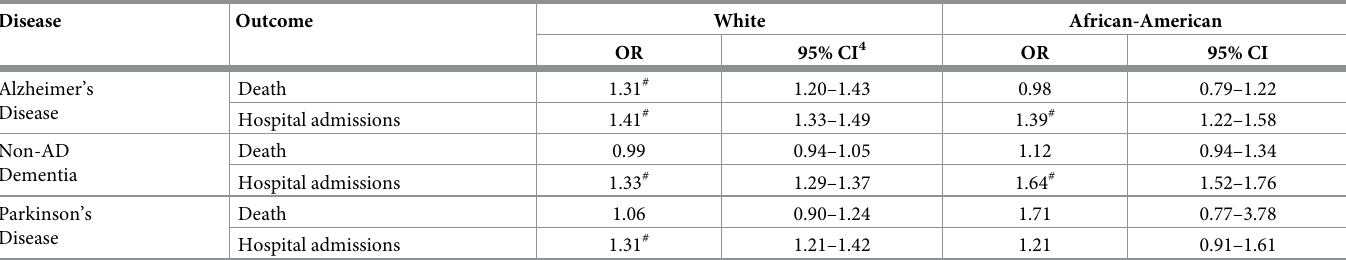
Table 4. Odds ratios (ORs) of death and hospital admissions in White and African-American populations 1 , either as primary or secondary cause 2 , multivariable analysis 3 . Disease